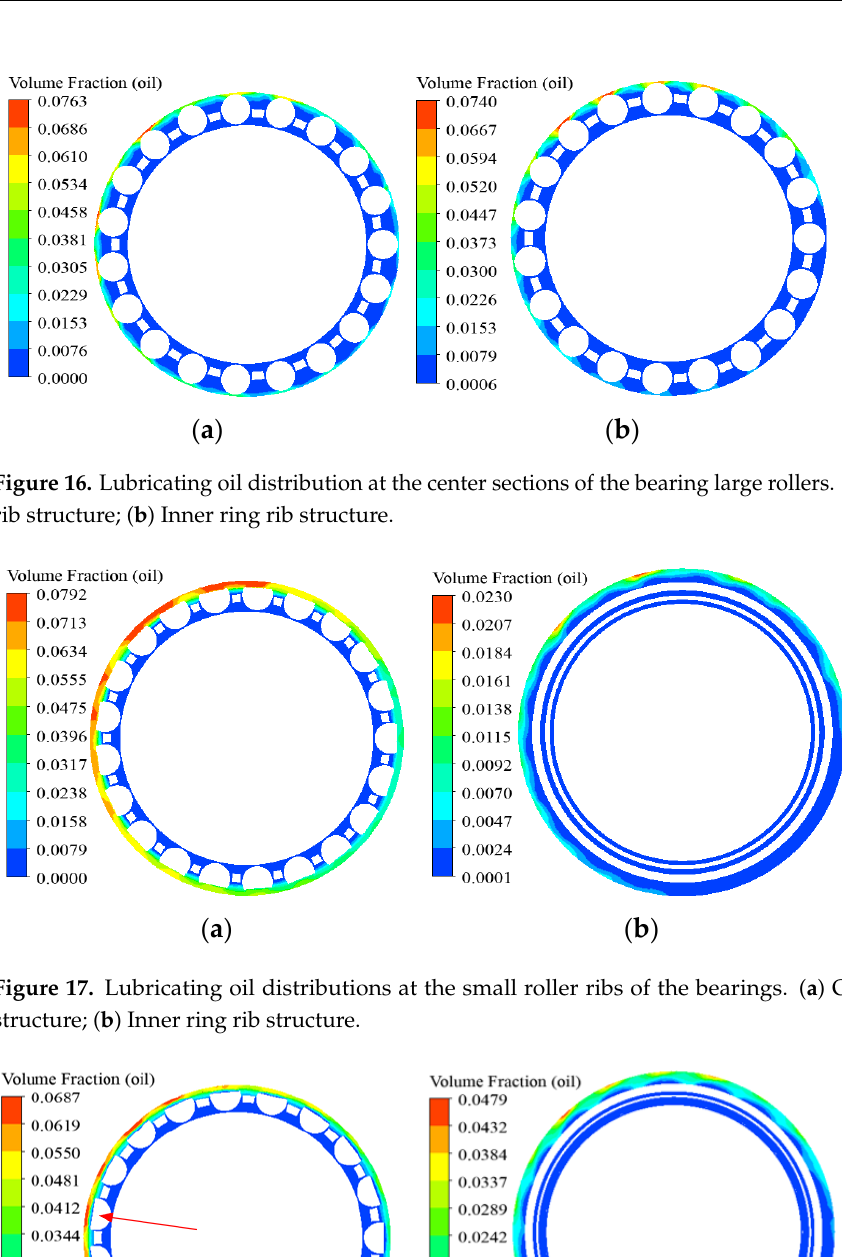
Figure 17. Lubricating oil distributions at the small roller ribs of the bearings. ( a ) Outer ring rib structure; ( b ) Inner ring rib structure.